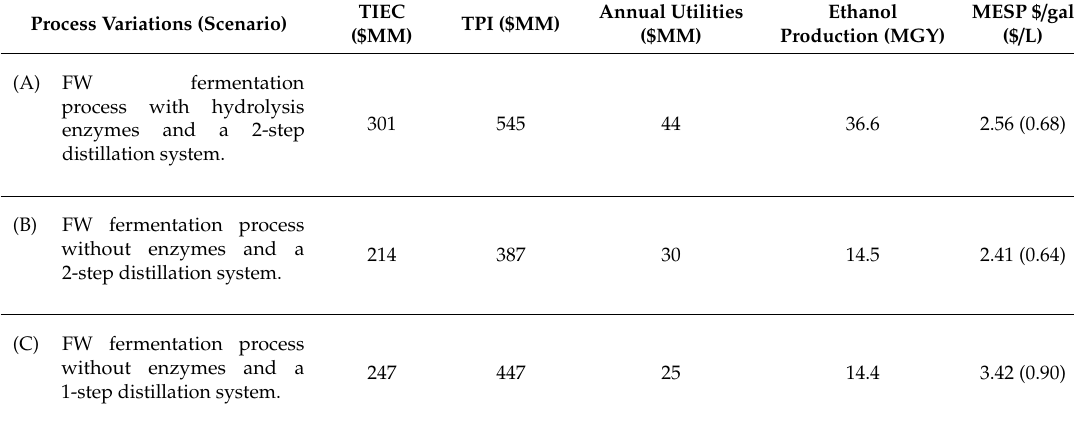
Table 4. Techno-economic analysis results (all results are in 2018 US